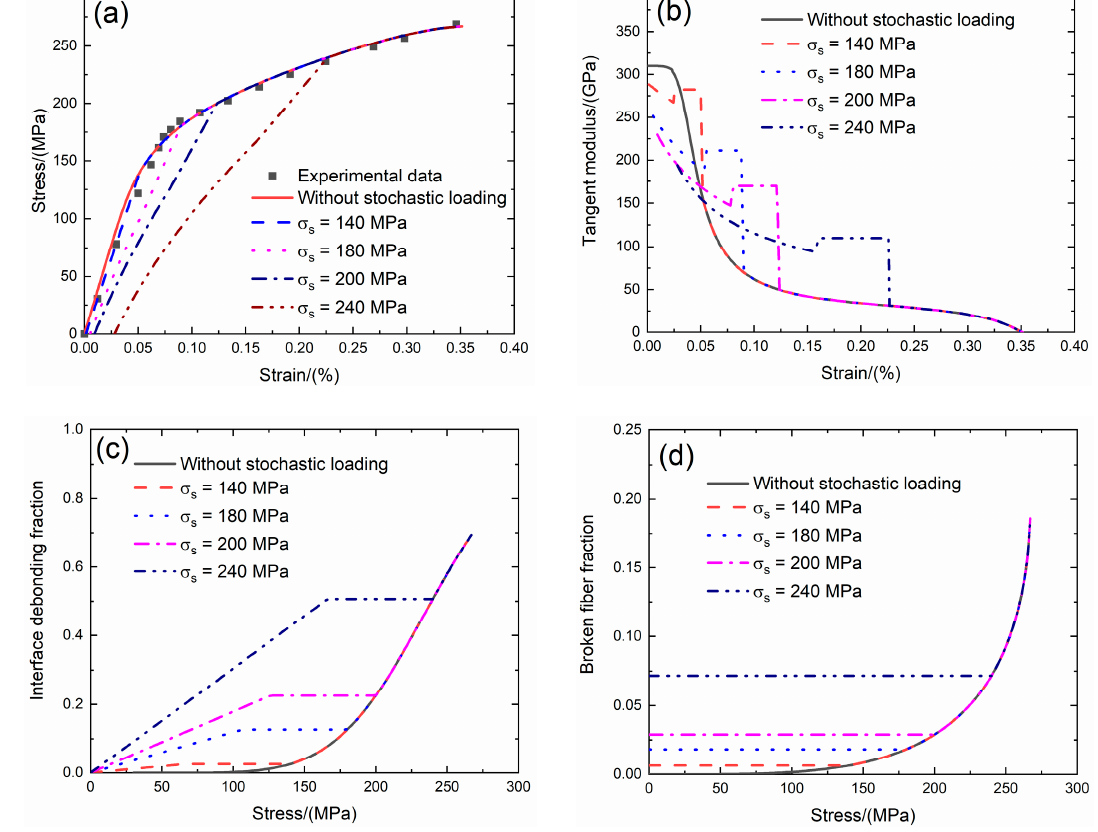
Figure 13. ( a ) The tensile stress–strain curves; ( b ) the tangent modulus versus strain curves; ( c ) the interface debonding fraction versus stress curves; and ( d ) the broken fibers fraction versus stress curves of 2D SiC / SiC composite for conditions without stochastic loading and with stochastic loading of σ s = 140, 180, 200 and 240 MPa. Table 6. The tensile stress–strain curve, tangent modulus, interface debonding fraction and broken fiber fraction of 2D SiC/SiC composite subjected to stochastic loading of σ s = 140, 180, 200 and 240 MPa.